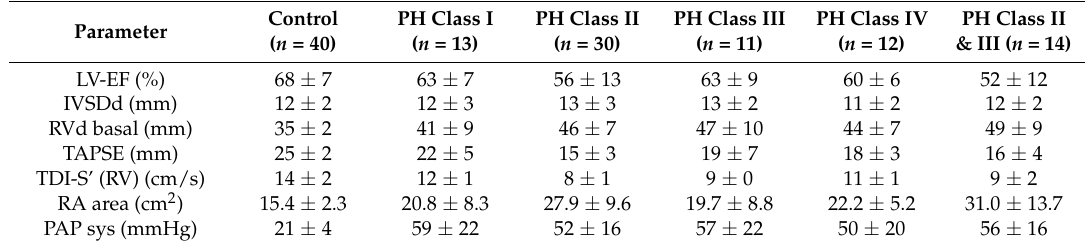
Table 2. Echocardiographic parameters of the study groups.